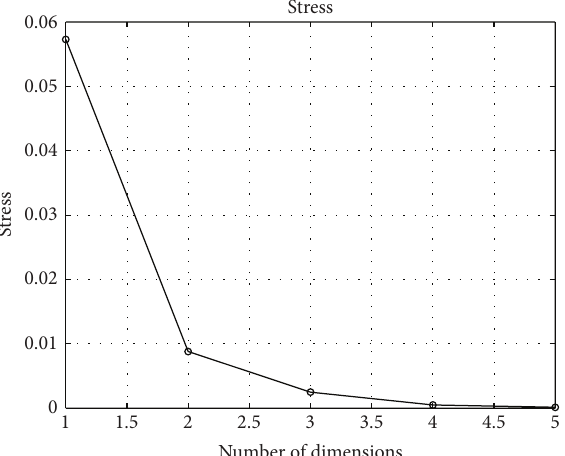
Figure 6: Stress plot of the MDS representation of the Portuguese economic evolution, with 𝑟 𝐶 , 𝑇 = 1865 – 2010 , ℎ = 2